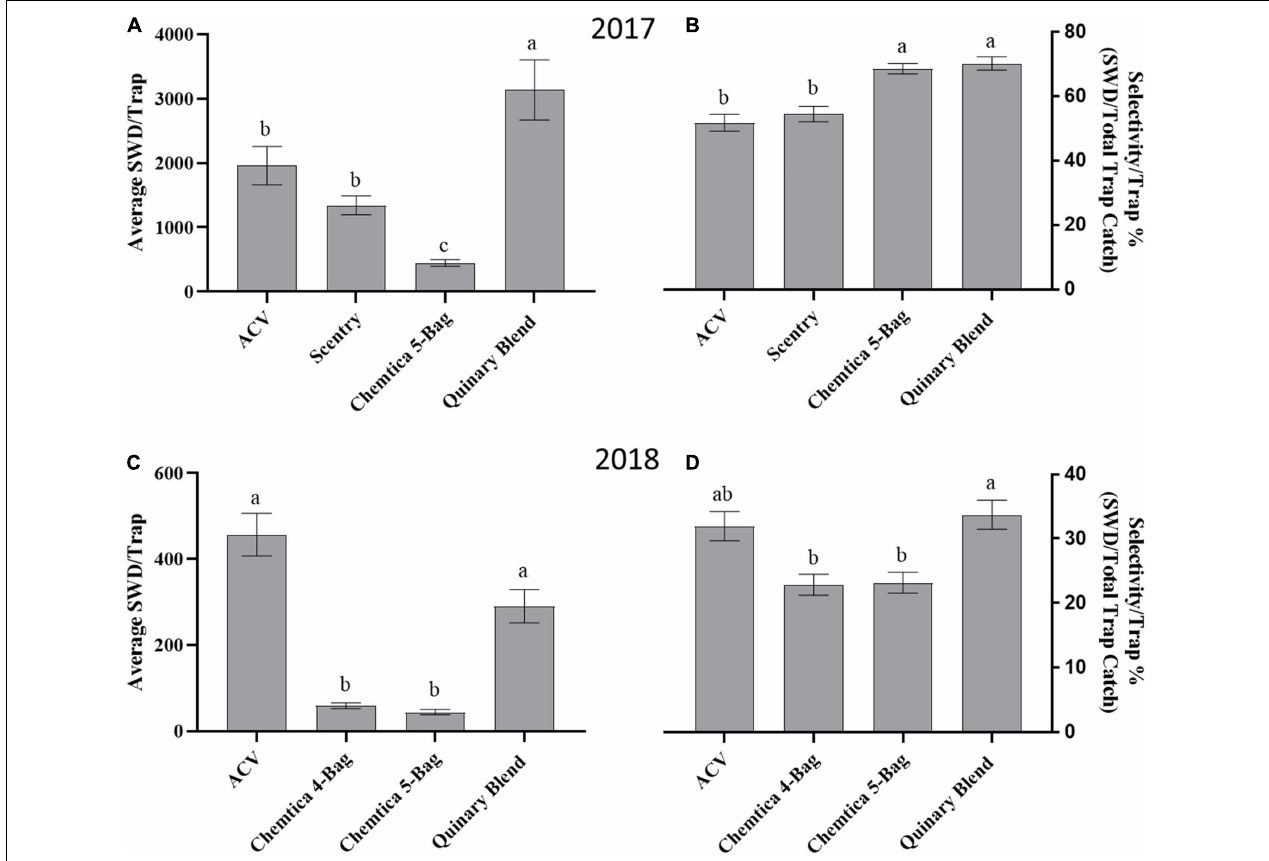
FIGURE 2 | Average SWD catch per trap and selectivity per trap for the entire trapping period in Maryland in a wooded area near the blueberry field in 2017 and 2018 by traps baited with ACV (apple cider vinegar), Scentry dispenser, ChemTica dispenser 5-bag, ChemTica dispenser 4-bag, and a quinary dispenser. (A) average catch in the wooded area in 2017 ( N = 539, df = 3, 535, F = 12.26, and P < 0.0001); (B) selectivity in the wooded area in 2017 ( N = 538, df = 3, 534, F = 18.41, and P < 0.0001); (C) average catch in the wooded area in 2018 ( N = 555, df = 3, 551, F = 24.54, and P < 0.0001); and (D) selectivity in the wooded area in 2018 ( N = 547, df = 3, 543, F = 4.733, and P = 0.0029). Means separated by One-way ANOVA with a Tukey’s post-test. Error bars represent standard error. Different letters above bars in each subfigure indicate significant differences at α = 0.05. Data represented are